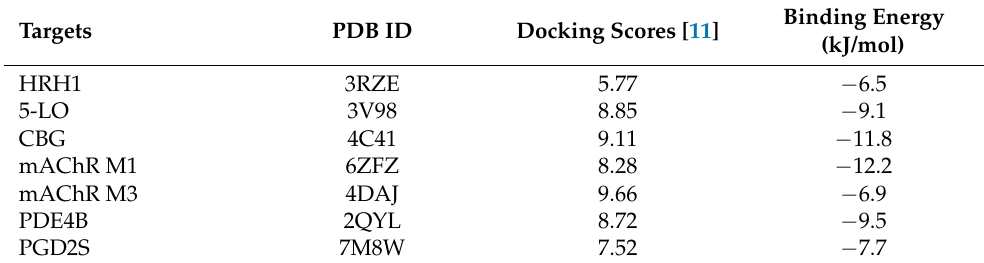
Table 1. Docking scores and binding energy of ALA with 5-LO, HRH1, CBG, mAChR M1, mAChR M3, PDE4B, and PGD2.